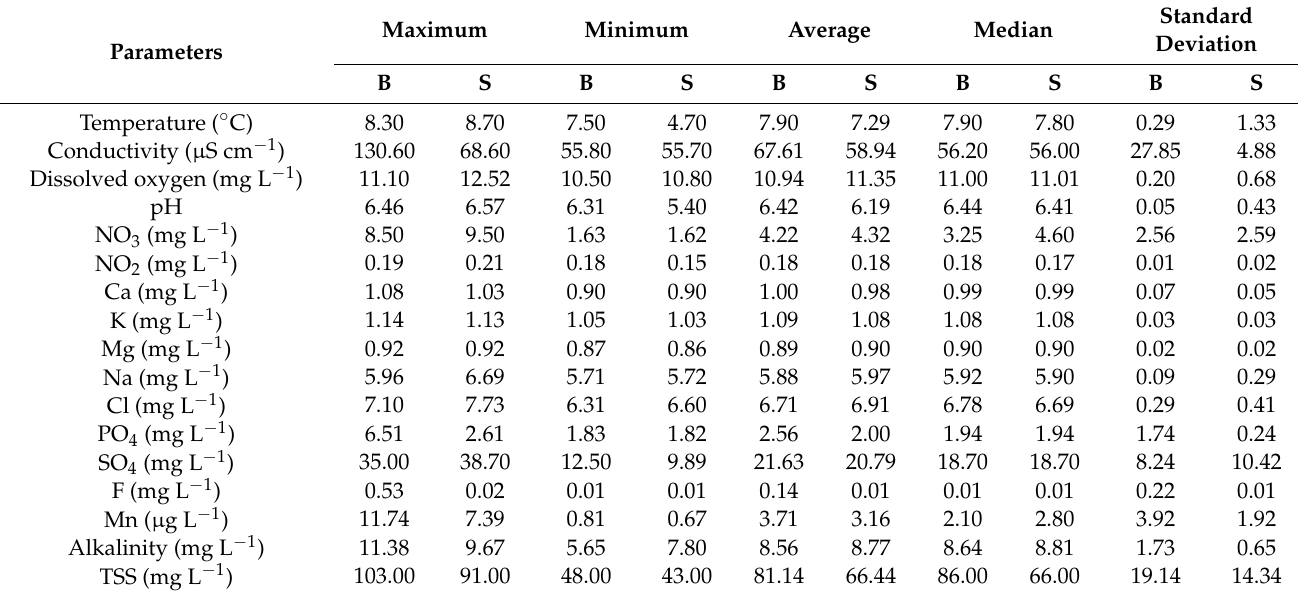
Table 1. Values of physical and chemical parameters of the surface and of the bottom of the water column in the Terragido reservoir (B—bottom water; S—surface water).